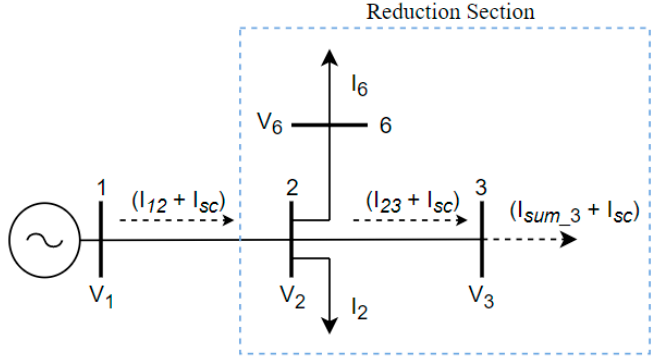
Figure 3. Single line diagram of reduction section 1 in fault condition.